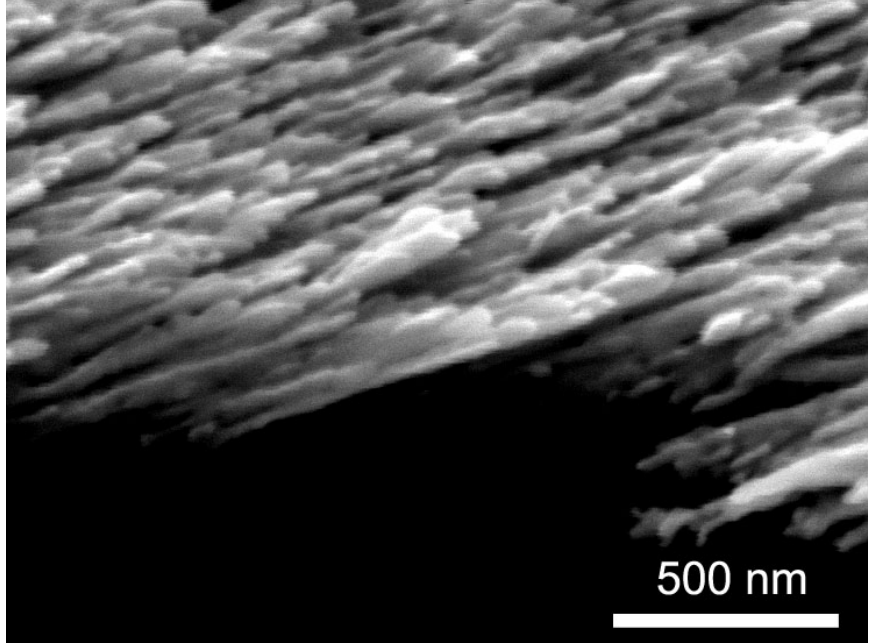
Figure 1. A typical SEM image showing the morphology of Ag nanorods used as the SERS substrates in this